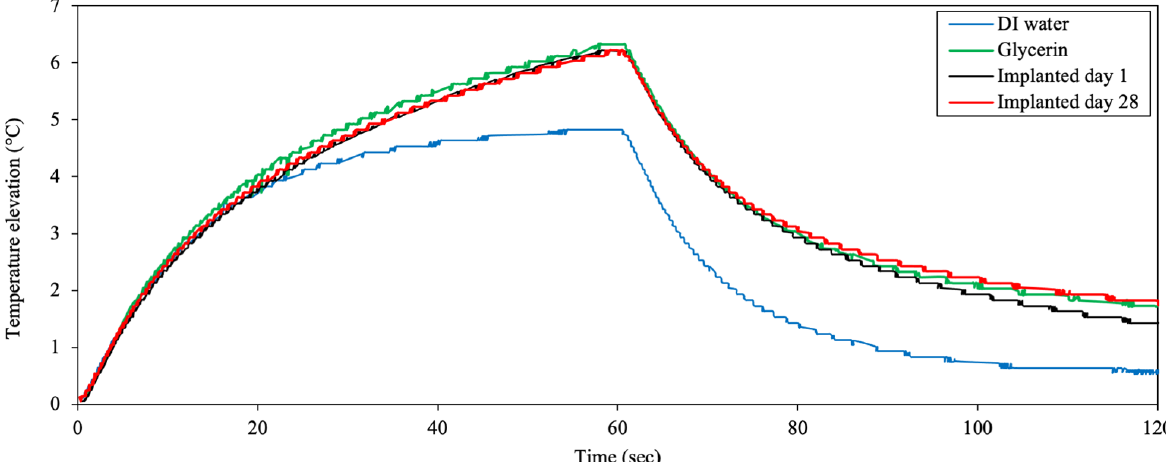
Figure A1. Temperature elevation in one of the side chambers due to heating of the middle chamber in different environments was studied to evaluate changes in the thermal properties of the subcutaneous environment over time and to find proper material for simulation of this environment for benchtop experiments. Comparison between the results of Day 1 and Day 28 after subcutaneous implantation showed insignificant changes in the thermal properties of this environment over time. Comparison of the results of the implanted data and the microsystem submerged in water and glycerin demonstrated suitability of glycerin for simulation of the thermal properties of the implanted environment for benchtop experiments.